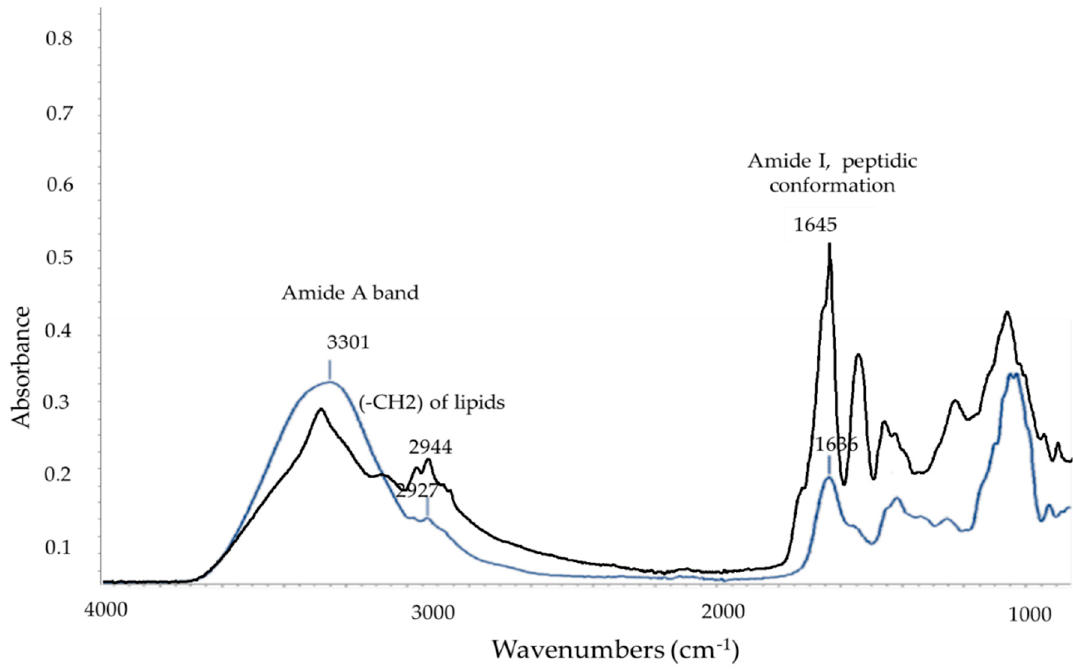
Figure 5. ATR-FTIR spectra of crude BSs from B3-15 ( blue ) and SBP3 ( black ) strains. In the FTIR spectra of BSs from the two strains, the peaks observed at 3301 cm − 1 were assigned to CH and OH groups of Amide A. The peaks observed at 2944 and 2927 cm −